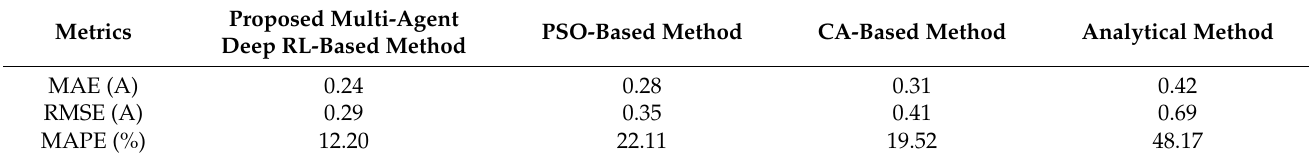
Table 3. Statistical results of annual errors.